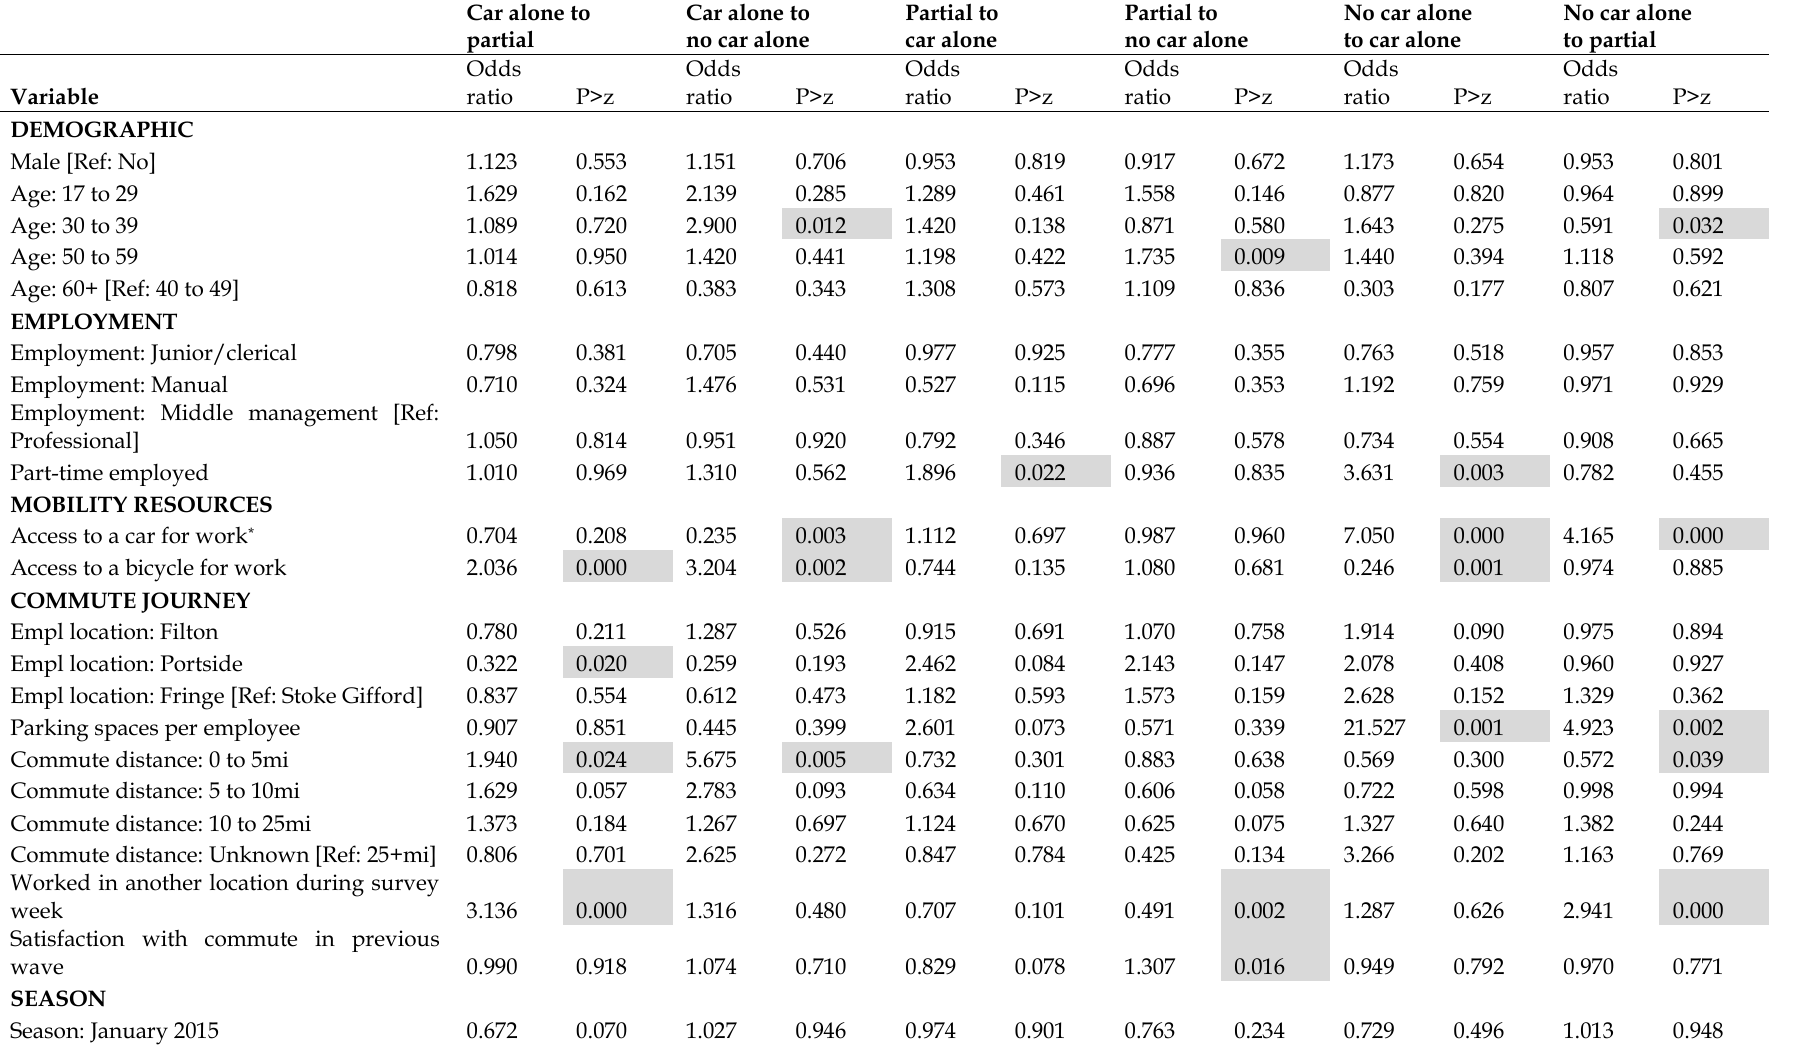
Table 11: Predictors of transitions between commuting mode choice patterns Car alone to